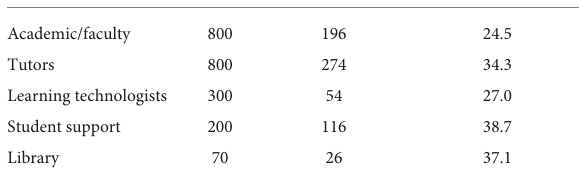
TABLE 2 Open University Mental Health project focus group participants.